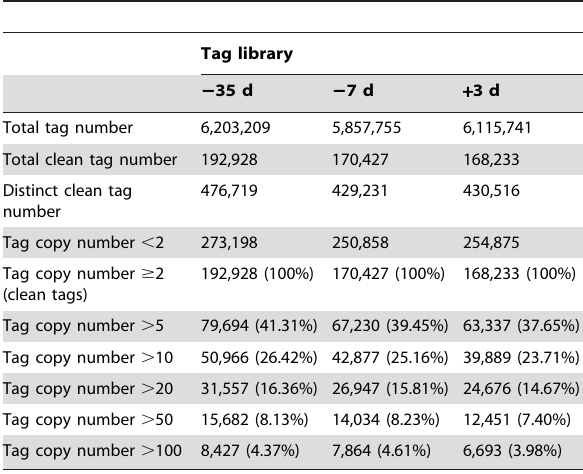
Table 1. Distribution of the tags sequenced from the three libraries.